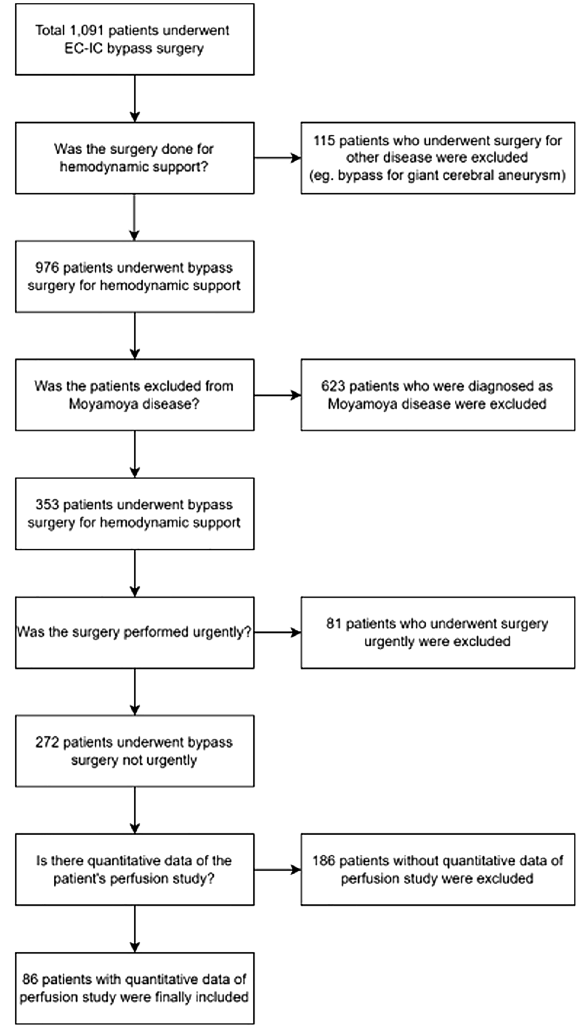
Figure 1. Flow diagram of the enrolled